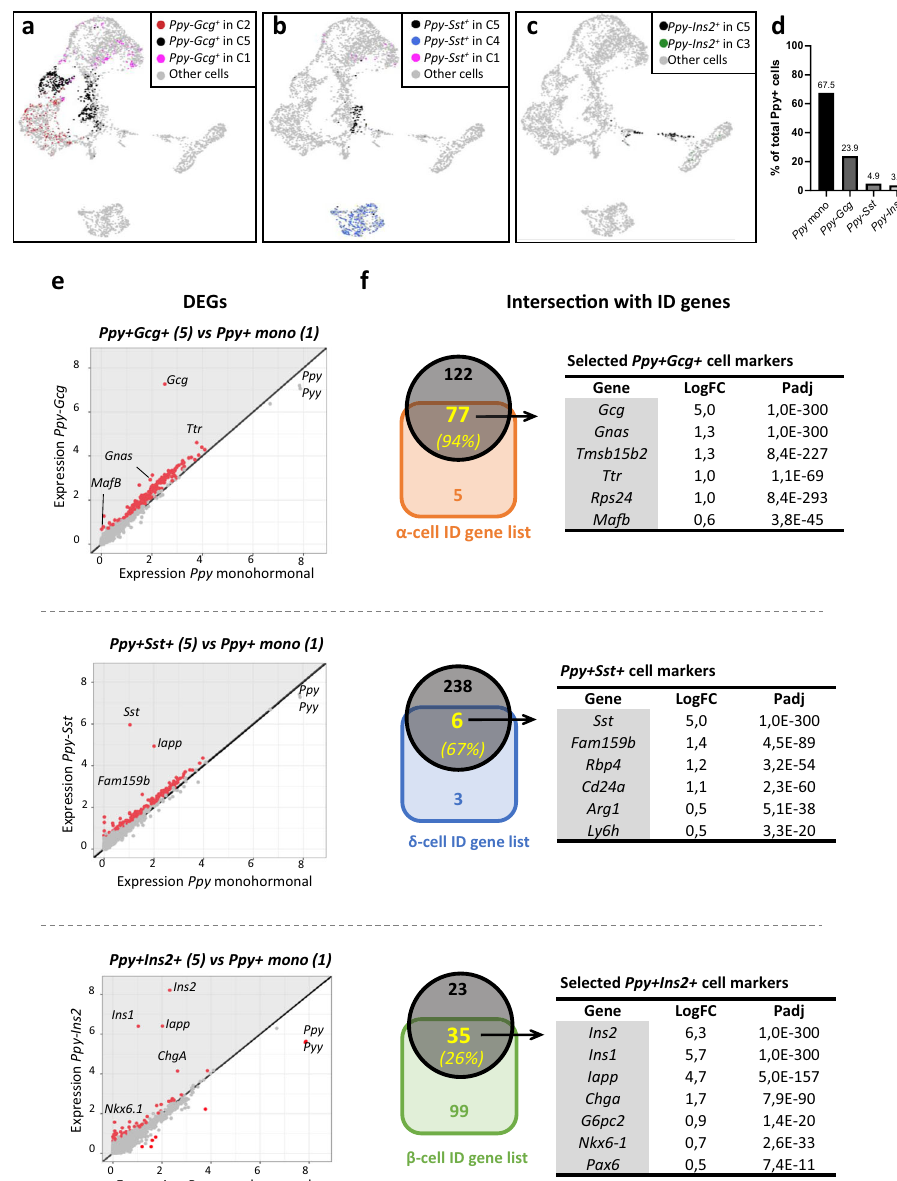
Fig. 5 Bihormonal γ -cells share identity genes with α -, δ - or β -cells. UMAP localization of the bihormonal Ppy + cells in the different clusters: Ppy + Gcg + ( a ), Ppy + Sst + ( b ) and Ppy + Ins2 + ( c ). Ppy + bihormonal cells located outside of Cluster 5 were excluded as they transcriptionally resemble to monohormonal α -, β - and δ -cells, but express Ppy . d Proportion of Ppy + cells expressing other islet hormones (1167 Ppy + , 415 Ppy + Gcg + , 84 Ppy + Sst + and 64 Ppy + Ins2 + cells). e Expression plot of differentially expressed genes (DEGs) between bihormonal Ppy + Gcg + (top), Ppy + Sst + (middle) and Ppy + Ins + (bottom) in cluster 5 and monohormonal Ppy -expressing cells in cluster 1. Each dot represents one gene. Red dots represent the genes with P value < 0.05 . Gene names label the top DEGs. Gray area indicates the upregulated genes in each bihormonal population. Differential expression was calculated using a negative binomial generalized linear model in a pairwise manner between populations, taking along the number of UMIs and the number of genes as variables to regress. P values (in panel f and Source Data l) are Bonferroni corrected based on the total number of genes in each dataset. f Intersection of the upregulated genes in Ppy + Gcg + (top) , Ppy + Sst + (middle) and Ppy + Ins + (bottom) from e , with mouse α -, δ - and β -cell ID gene lists. Important markers of the adult α -cells (77 out of 82), δ -cells (6 out of 9) and β -cells (35 out of 134) are shared with the bihormonal Ppy -expressing cells. Source data are provided as Source Data fi le (Supplementary Table l).